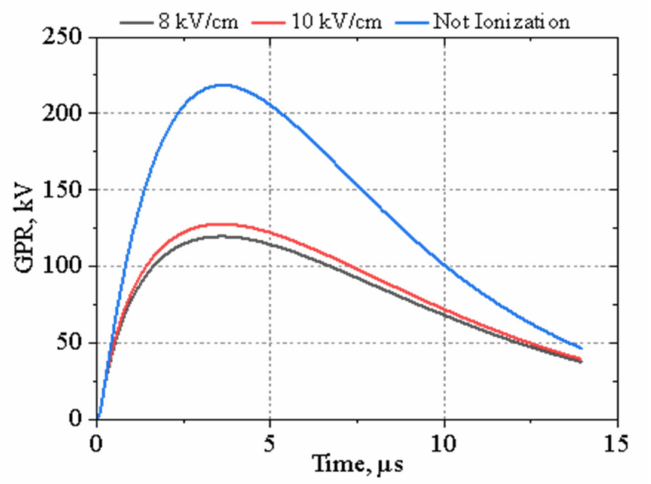
Figure 15. Transient ground potential rise produced in a vertical rod of 1.5 m, soil resistivity of 160 Ω m and a peak current of 2.35